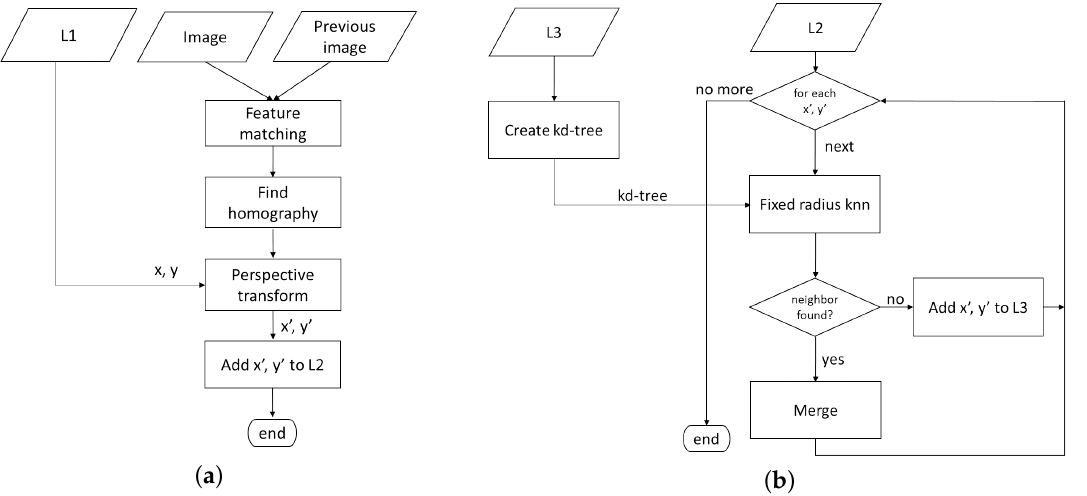
Figure 7. Flowcharts of the registration and merge algorithms (L1 is the list with the pixel coordinates of the trees detected in the image; L2 is the same list with pixel coordinates projected to a global reference system; and L3 is the list with the coordinates of the trees detected in all the processed images without duplicates). ( a ) Registration. ( b )